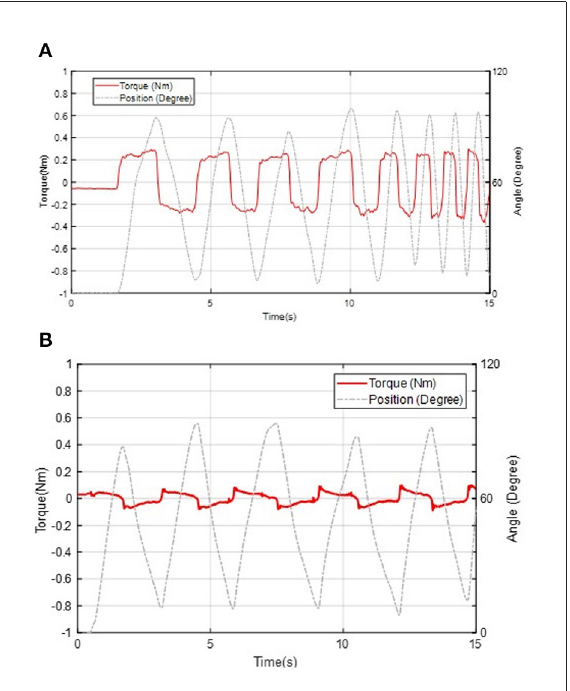
FIGURE10 Backdrivability performance of the knee exoskeleton in unpowered mode (A) and zero-torque control mode (B)